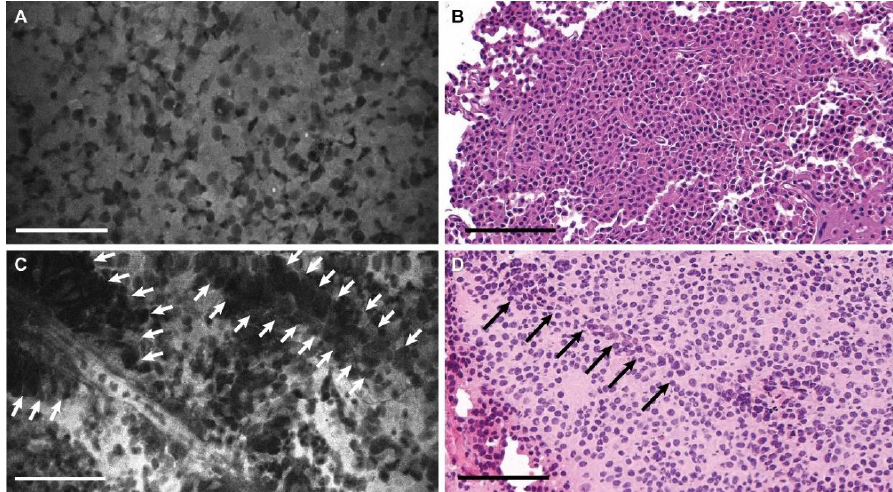
Figure 2. Photomicrographs of a pituitary adenoma. ( A ) Confocal laser endomicroscopy (CLE) image (see Supplementary Video S1) and ( B ) hematoxylin and eosin (H&E) stain of the same tumor showing sheets of uniform nonlobulated cells with prominent nuclei. ( C ) CLE image (see Supplementary Video S2) and ( D ) H&E image showing perivascular sheets of the cells ( arrows ). Bar = 100 µ m. Used with permission from Barrow Neurological Institute, Phoenix,